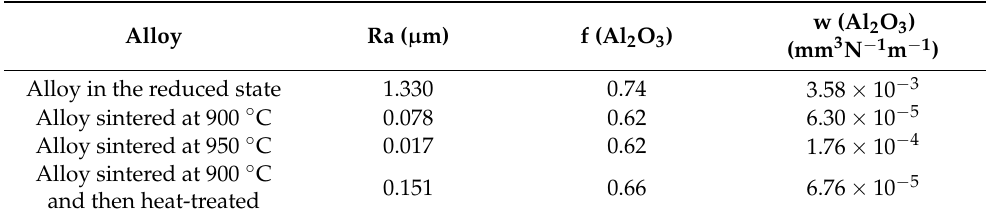
Table 7. Tribological properties of tested alloy against Al 2 O 3 ball. Ra—roughness of the surface, f—friction coefficient, w—wear